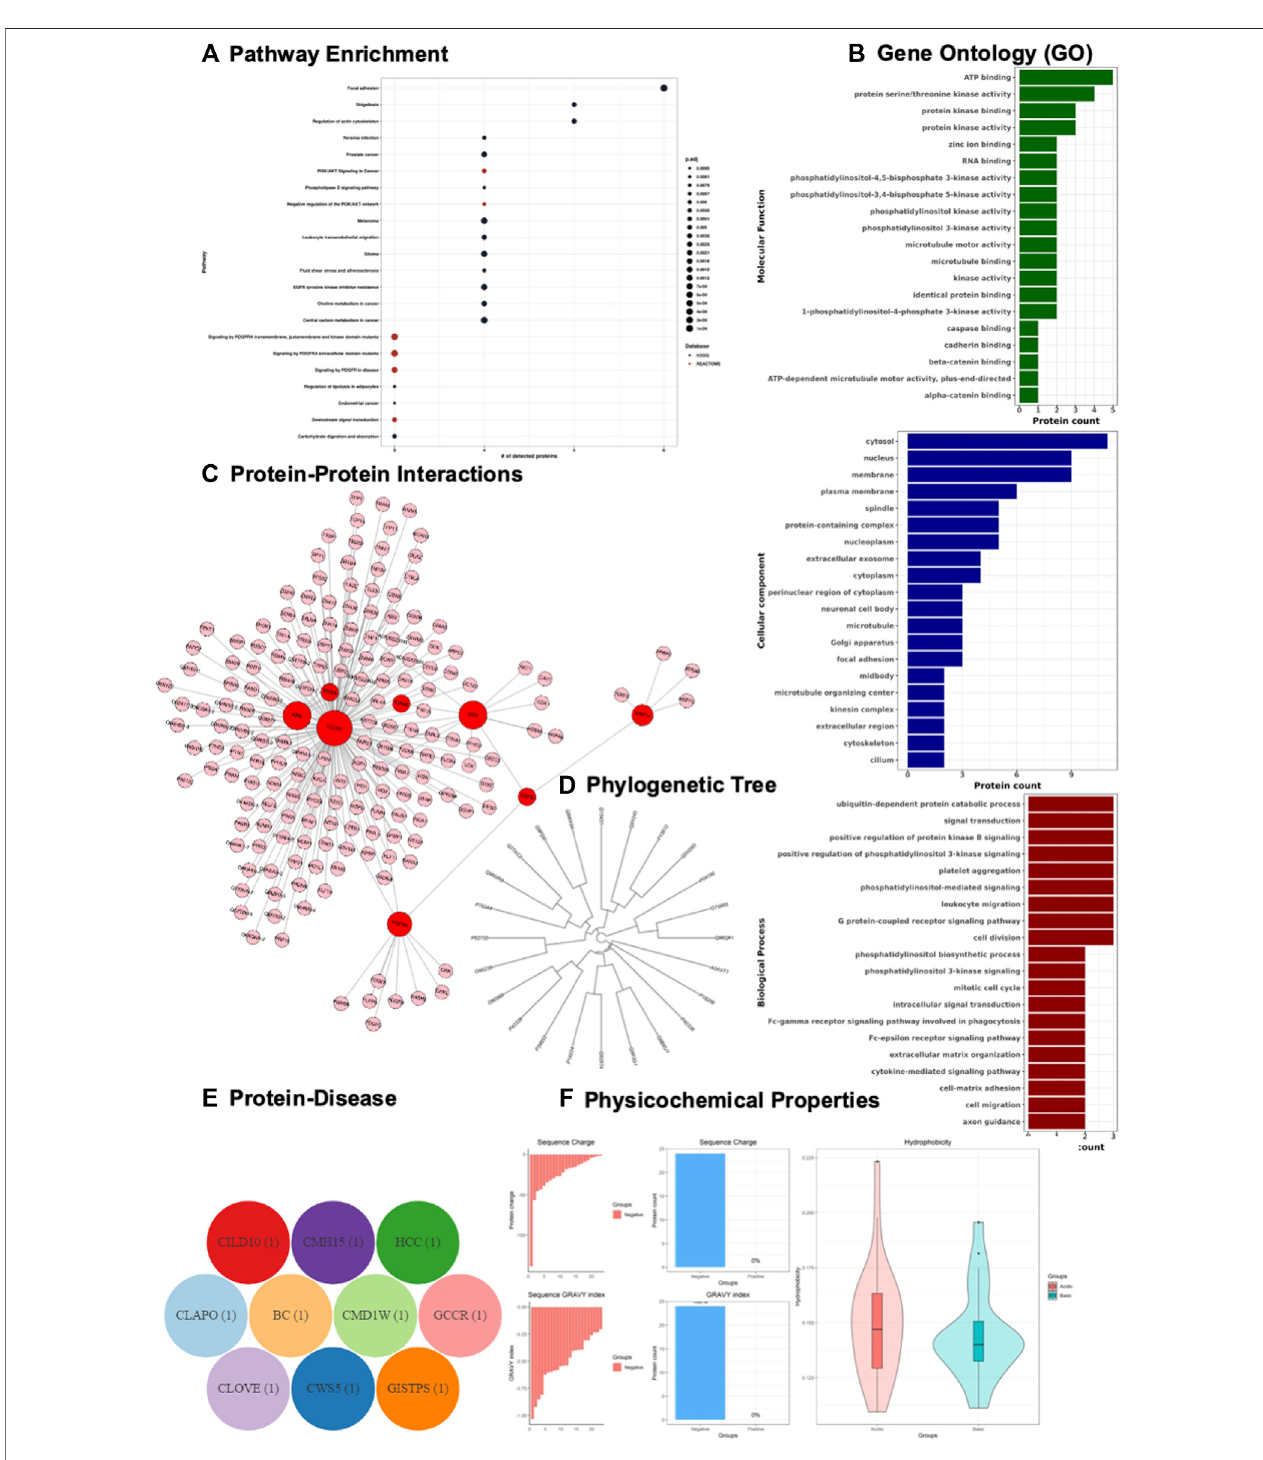
FIGURE 4 | Demonstration of Gene and Protein Bioinformatics Analysis using GeneCloudOmics. (A) pathway enrichment analysis, (B) gene ontology (GO), (C) protein-protein interaction, and (D) protein phylogenetic analysis, (E) protein pathological analysis, and (F) Protein physicochemical properties (acidity, charge and hydrophobicity) of Scutellarein treated AGS cell lines of gastric cancer proteomics dataset.